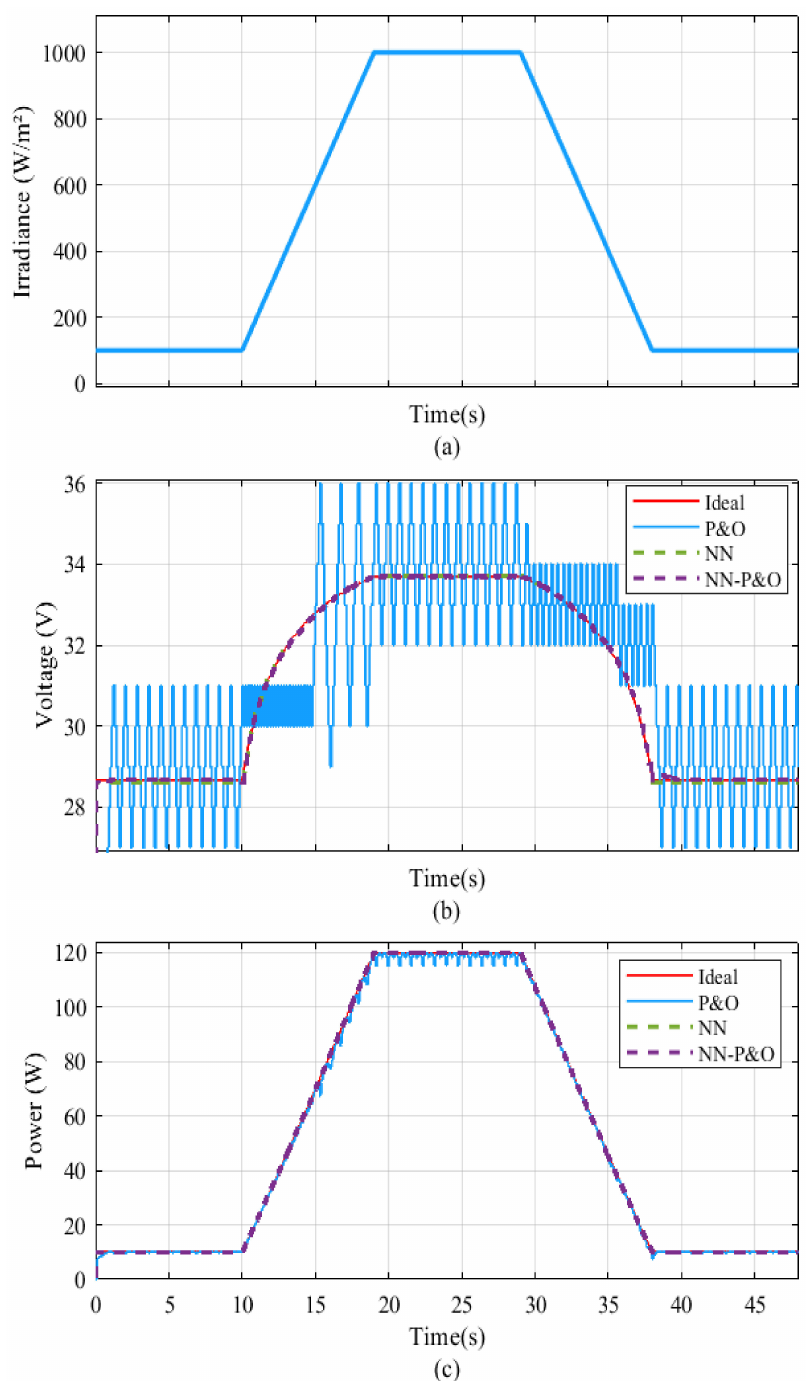
Figure 9. Simulation results under a slope of 100 W/m 2 /s: ( a ) irradiance, ( b ) voltage, and ( c )